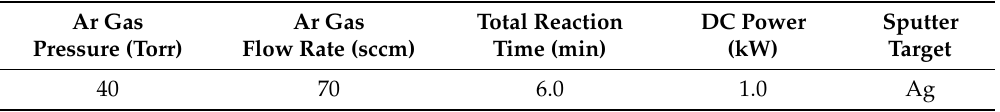
Figure 2. Schematic diagram of the direct current (DC) sputtering system used to produce Ag-coated c-NFs.